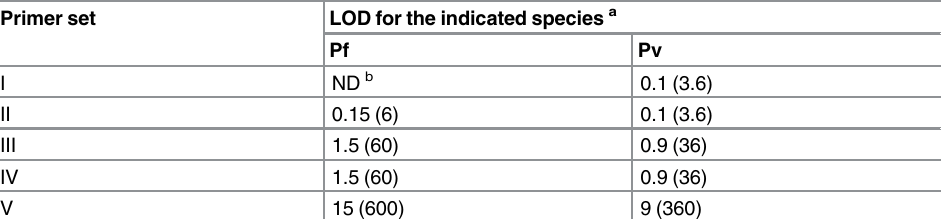
Table 6. Determination of the limit of detection (LOD) using calibrated standards of Pf and Pv sporozoites. Primer set LOD for the indicated species a Pf Pv I ND b 0.1 (3.6) II 0.15 (6) 0.1 (3.6) 1.5 (60) 0.9 (36) 1.5 (60) 0.9 (36) V 15 (600) 9 (360) LOD , limit of detection; ND , not determined; Pf , Plasmodium falciparum ; Pv , Plasmodium vivax . a limits of detection are expressed in number of Plasmodium falciparum and Plasmodium vivax genome equivalent (Pfg and Pvg) per reaction tube, values into brackets represent the corresponding number of sporozoites per mosquito. b due to the lack of sample, it was not possible to determine the LOD of the primer pair I for Pf sporozoites. According to the score values presented in the Table 3, the LOD determined with the primer pair I should be similar to the LOD determined with the primer set II for Pf sporozoites (6 Pf sporozoites per mosquito).